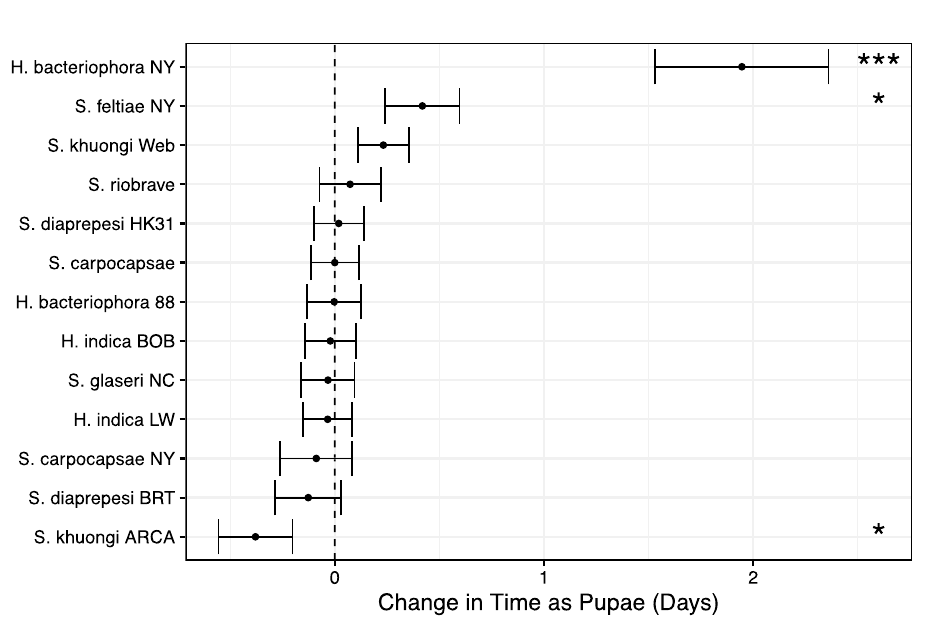
Figure 3. Change in time D. antiqua spent as pupae as compared to paired controls not inoculated with EPN strains. Points and error bars denote means and standard error respectively. Asterisks (*, **, and ***) denote significance at p < 0.05 , p < 0.01 , and p < 0.001